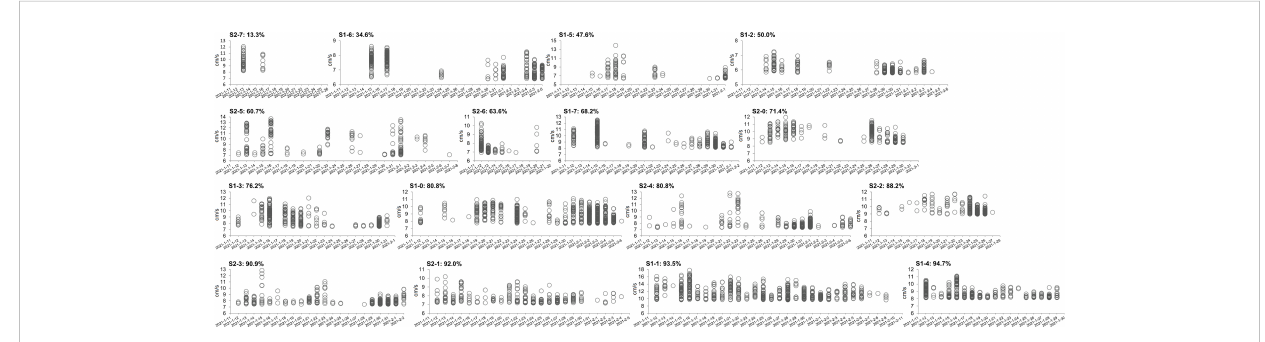
FIGURE 5 Distribution of intense valve movements among the scallops. Only the top 5% valve movement events of each scallop were selected based on the order of their velocities. The percentage of each graph represents the ratio of the days with the top events to the total survival days of each scallop. The order of graphs in the fi gure is based on their